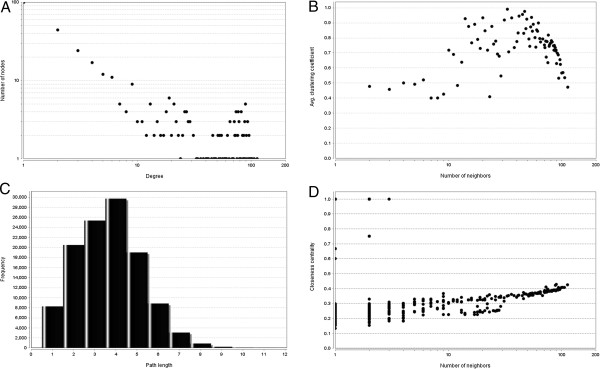
Topological properties of the protein-protein interaction network. (A) The degree distribution; (B) Average clustering coefficient; (C) Shortest path length distribution; (D) Closeness centricity.